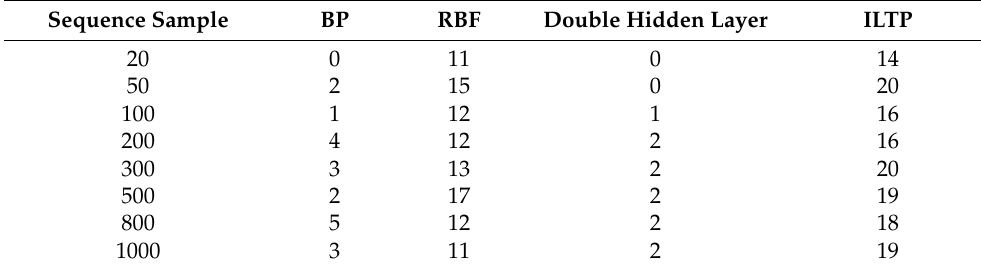
Table 4. Comparison results of prediction steps.